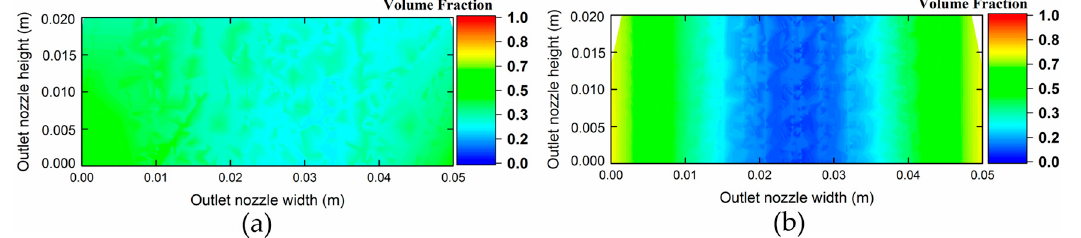
Figure 16. Spatial distributions of volume fraction in the outlet nozzle for mixing chamber: ( a ) with obstacles; and ( b ) without obstacles at 10.0 s. Blue color (i.e., volume fraction = 0) represents blood while red color (i.e., volume fraction = 1) represents plasma.